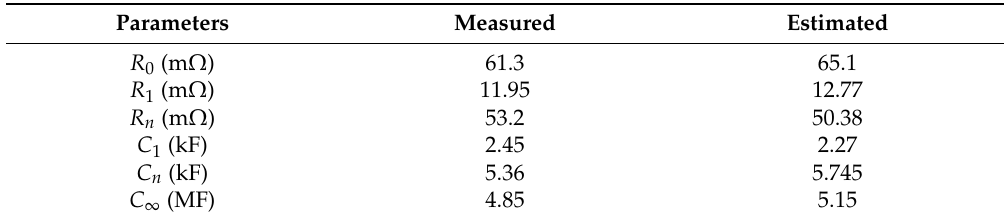
Table 18. Results of Case 5 for Pb.